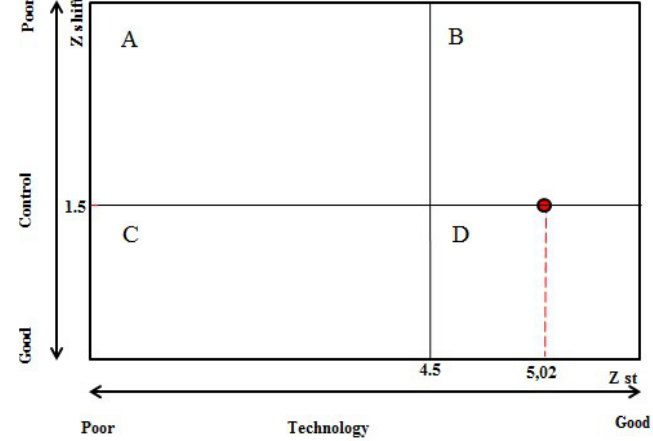
Fig. 8 . Four Block diagrams of sigma level after improve